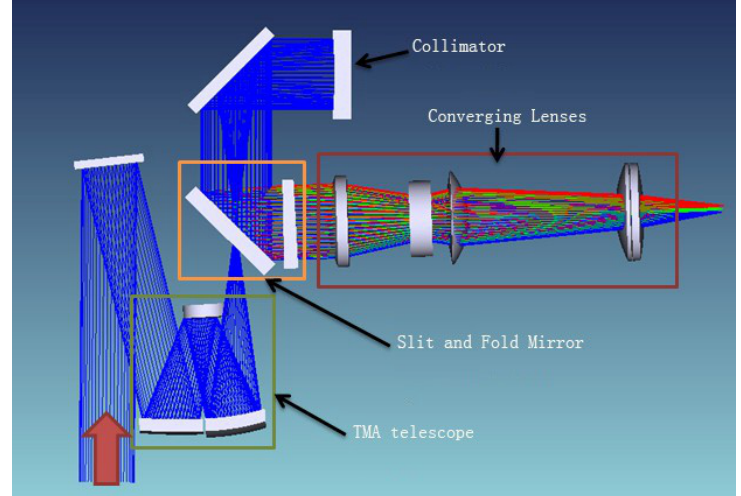
Figure 2. Optical system of WiSHiRaPHI.